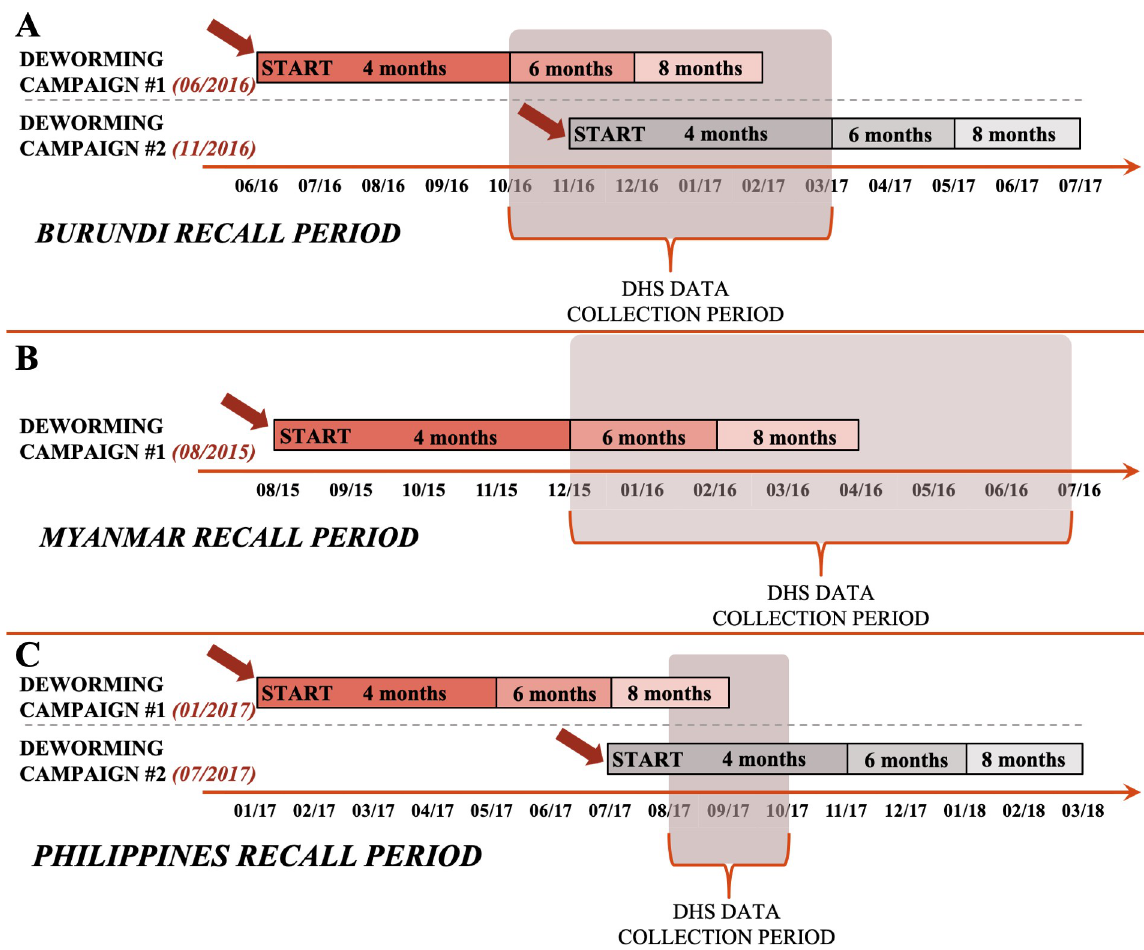
Fig 1. Timeline of national deworming campaigns reported to WHO for pre-school aged children and DHS data collection periods in study countries. We obtained sub-national deworming coverage data reported to WHO and estimated by DHS across comparable timelines. We used WHO data on programmatic deworming to determine national deworming campaign start dates (dates on left-hand side and time- axis in month/year, e.g. 06/2016 is June 2016) and estimated coverage for Burundi (panel A), Myanmar (panel B) and the Philippines (panel C). We used DHS data from each country to estimate deworming coverage by matching respondents to the corresponding deworming campaigns, based on the survey date and recall period in the orange/gray bars (base, 6-month recall; alternatively, 4- or 8-months based on the sensitivity analysis) that represents the accepted time period (months) after deworming campaign